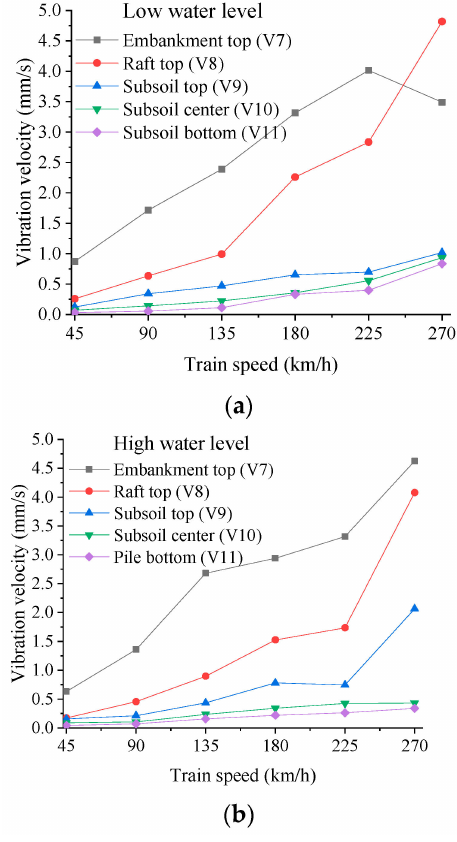
Figure 17. Relationship between vibration velocities and train speed at V7 to V11. ( a ) low water level ( b ) high water